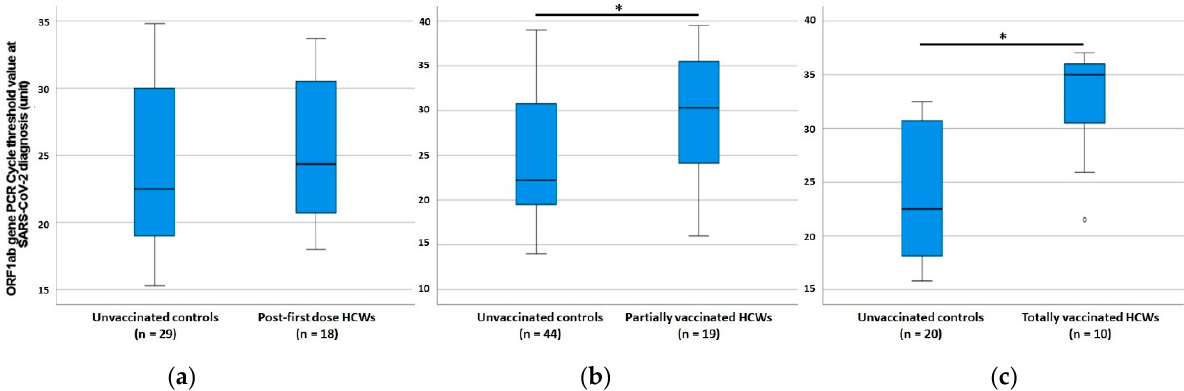
Figure 2. Comparison of SARS-CoV-2 PCR cycle threshold values across the study population. Comparison of PCR cycle Table 2. diagnosis between corresponding unvaccinated sex- and age- matched controls and post-first dose vaccinated health care workers ( a ), partially vaccinated health care workers ( b ), and totally vaccinated health care workers ( c ). Legend: HCWs, health care